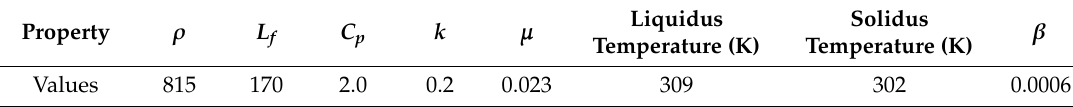
Table 2. Thermo-physical properties of RT35